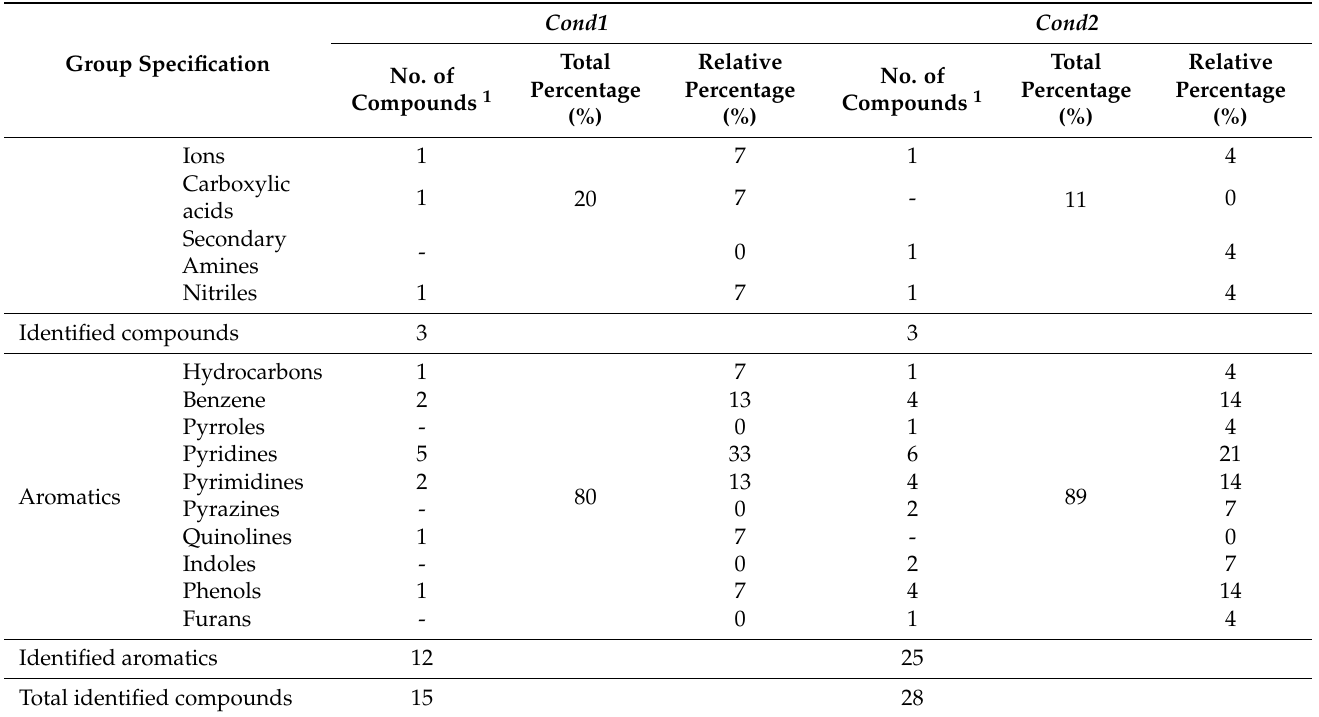
Table 3. Distribution by chemical group of the compounds identified by GC-MS in the condensates that were obtained by gasification of WST at 850 ◦ C ( Cond1 ) and SW at 750 ◦ C ( Cond2 ) in a BFB